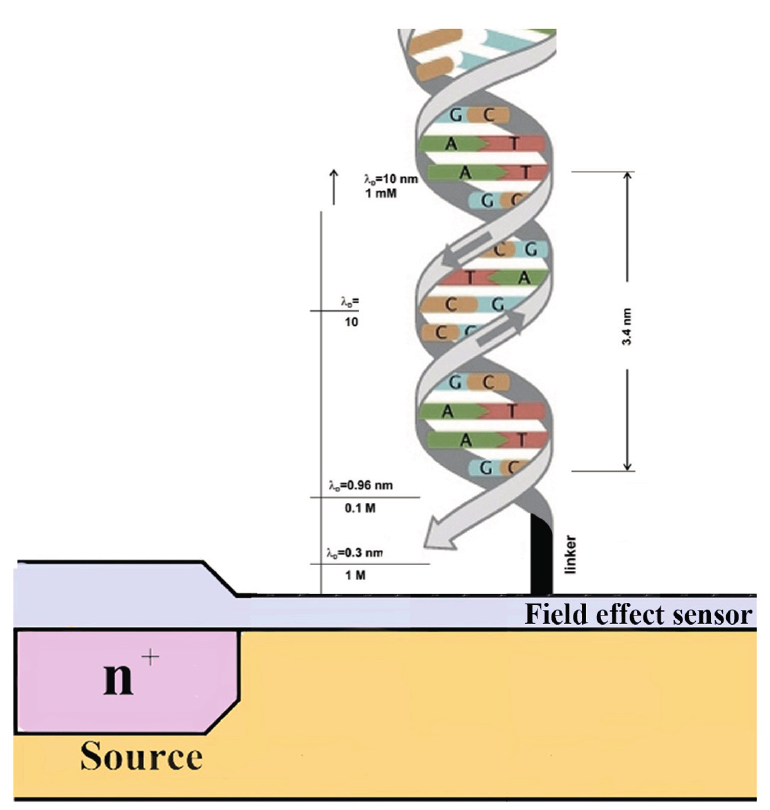
Figure 2. Schematic illustration of a DNA covalently bound to a sensor surface and Debye length ( λ D ) in electrolyte with different ionic strengths. Reduction of the buffer ionic strength allows for the detection of interaction events at larger distances from the sensor